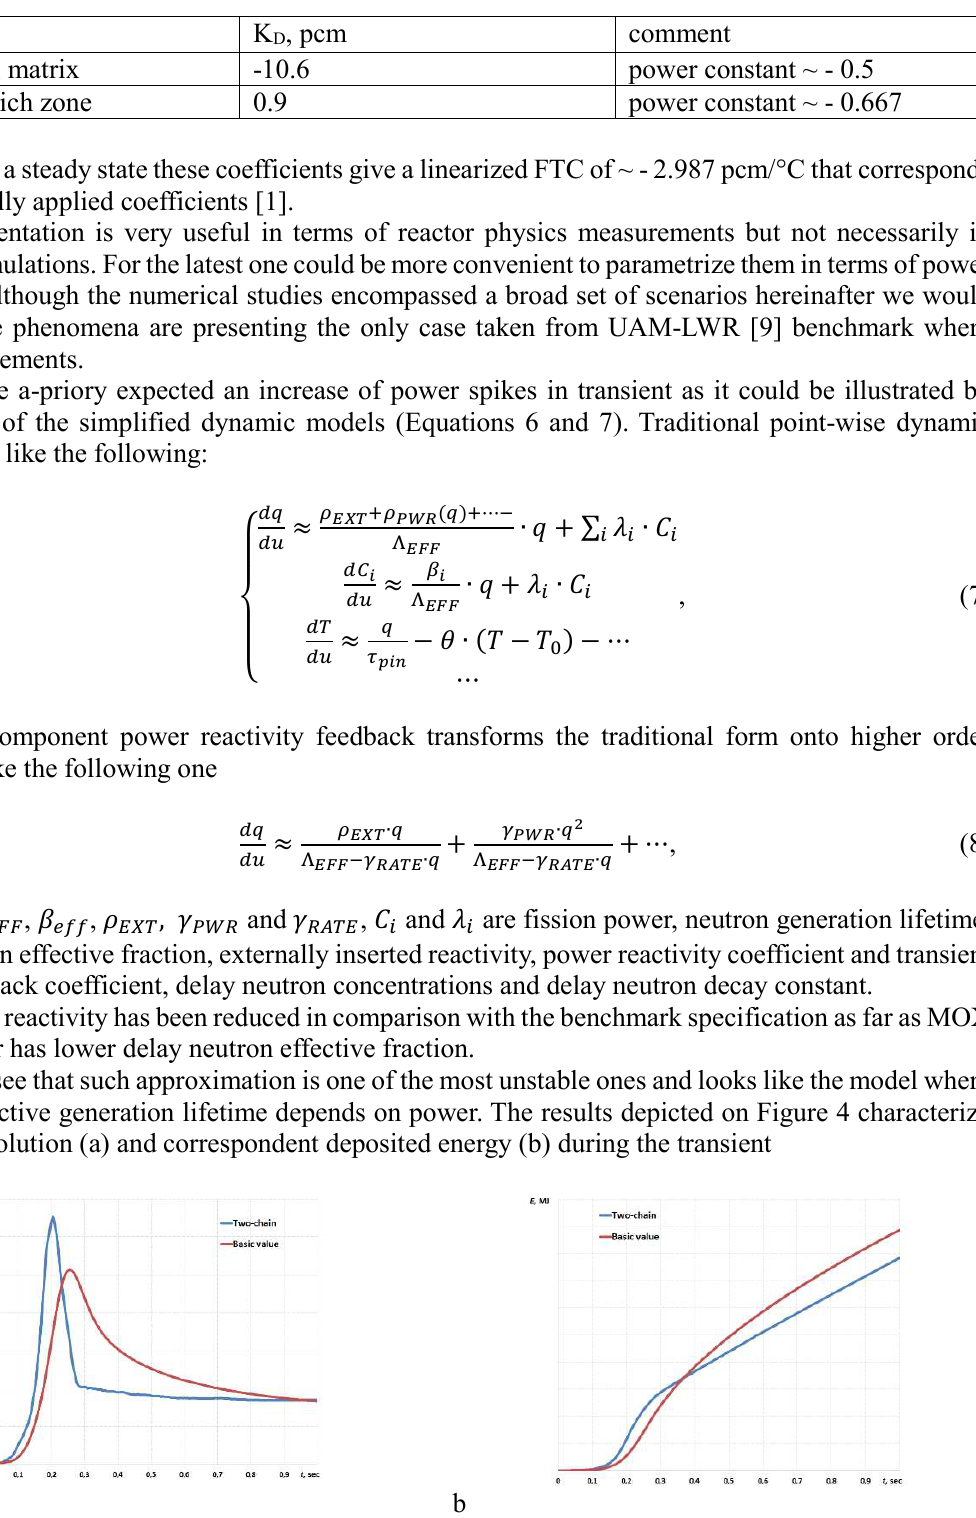
Table I: Doppler-based components of FTC due to uranium oxide and Pu-rich zones